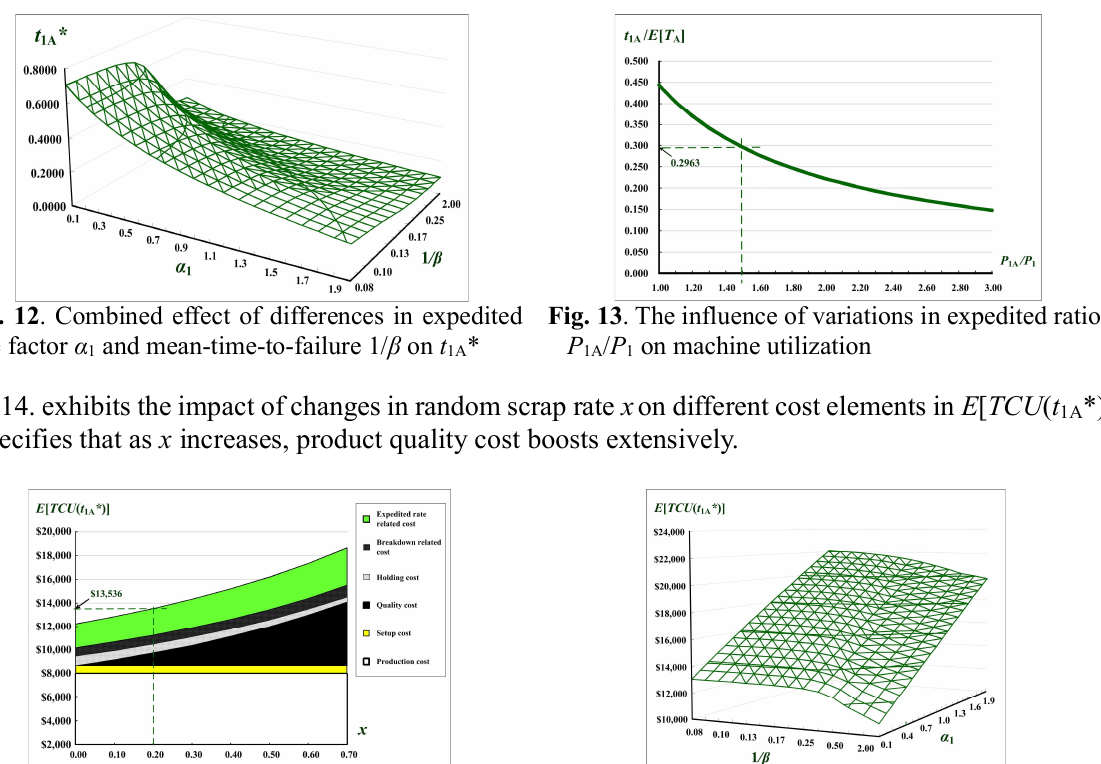
Fig. 14. The impact of variations in random scrap rate x on different cost contributors of E [ TCU ( t 1A *)]